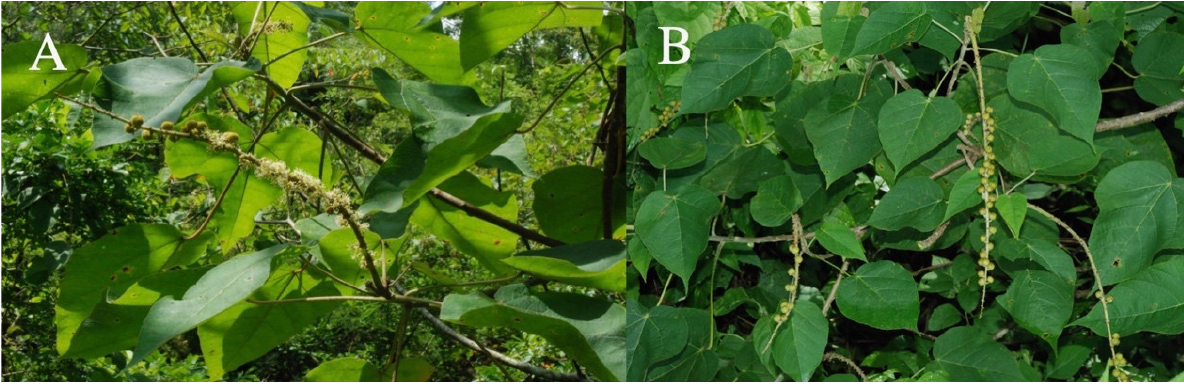
Figure A6. Croton draco. ( A ) Branch with flowers and fruits. ( B ) Branches with